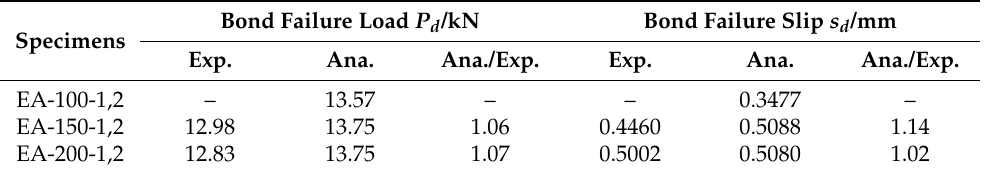
Table 3. The P d and s d from experimental and analytical